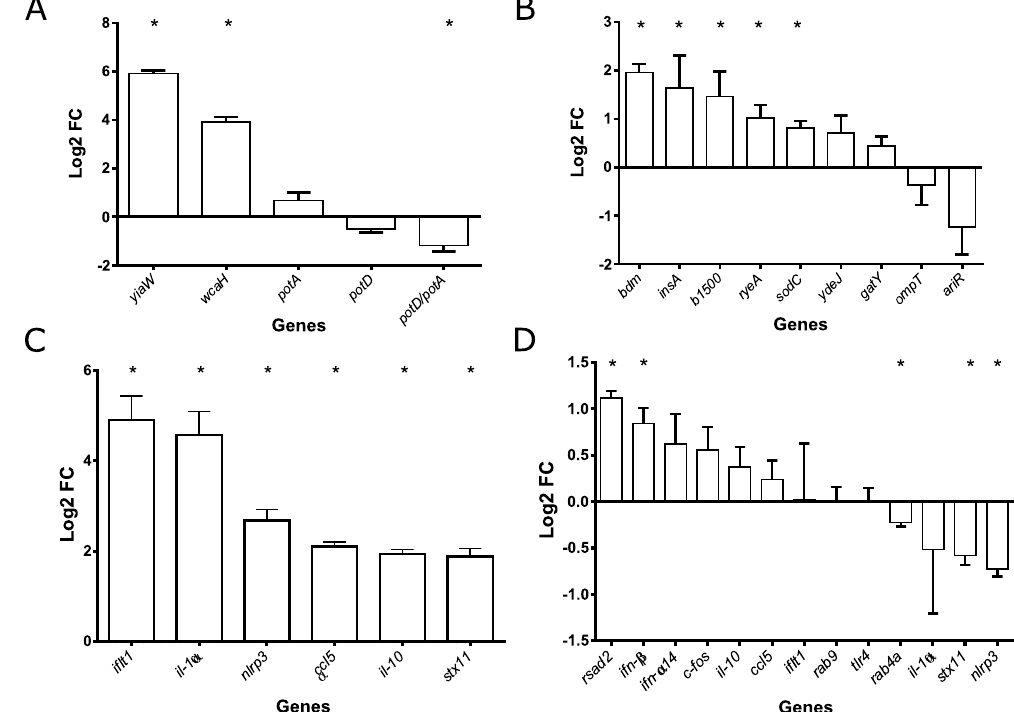
Figure 3. Host and pathogen gene expression at 1 h post-infection. Values represent the average (log2) fold change detected by RT-qPCR from three independent experiments. Error bars represent SEM. ( A ) Expression values of yiaW , wcaH , potA , potD and potD relative to potA in the M6 strain relative to Anc, at 1 h post- infection. ( B ) Confirmation of differential expression of the top 9 differentially expressed transcripts identified by E . coli Genome 2.0 Array for M6 bacteria relative to Anc 1 h post-infection. ( C ) Confirmation of differential expression of 6 of the 1110 differentially expressed transcripts (Padjusted < 0.05) detected by Mouse Gene 2.1 ST Array between infected and uninfected M Φ s. ( D ). Relative expression values of 13 out the top 2,881 differentially expressed transcripts (P < 0.05) identified by Mouse Gene 2.1 ST Array between M Φ s infected with Anc and M6 strains at 1 h